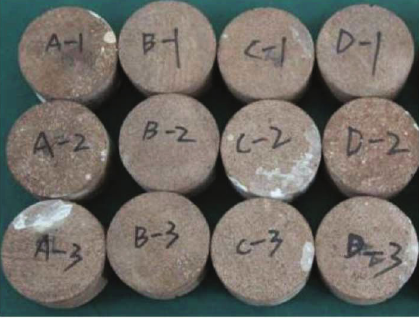
Figure 2: Sandstone